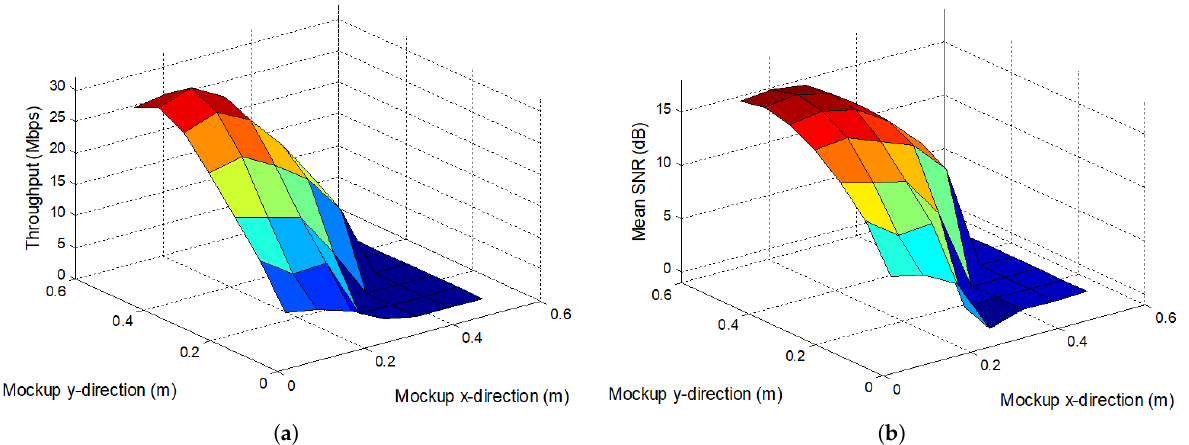
Figure 14. Experimental results with mockup when just one lamp is used to transmit data: ( a ) Measured throughput ( R max = 31.1 Mbps, R mean = 17.3 Mbps, R min = 0.9 Mbps for locations where communication was possible). ( b ) Measured mean SNR (SNR max = 17.3 dB, SNR mean = 13.5 dB, SNR min = − 0.9 dB for locations where communication was